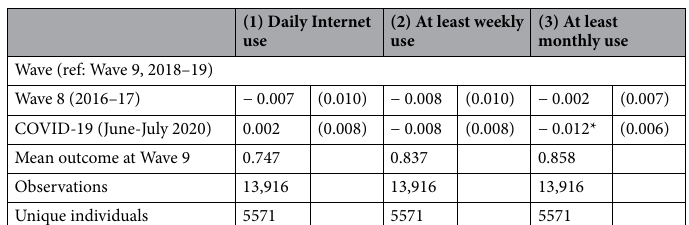
(1) Daily Internet use